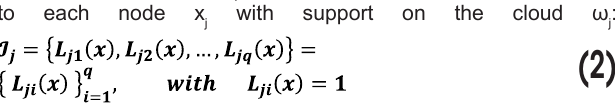
Strategy of enrichment of the cloud ω